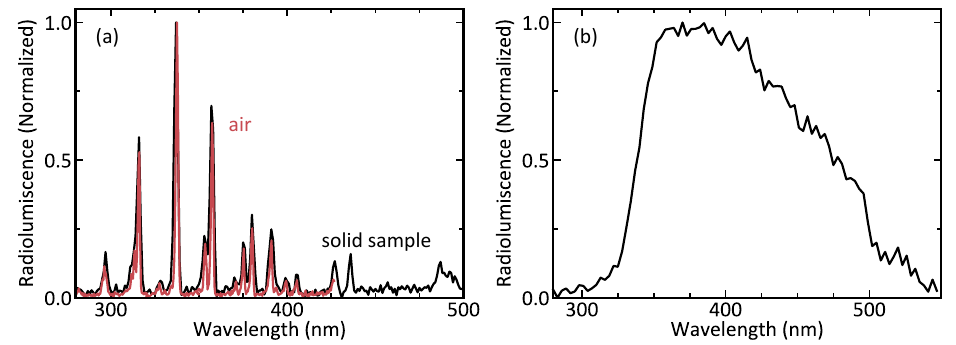
Figure 7. The normalized radioluminescence spectra of ( a ) light created by the solid sample (black) contrasted with this of air (red, data from [19]) ( b ) 750ppm Am-241 in 3M HNO 3